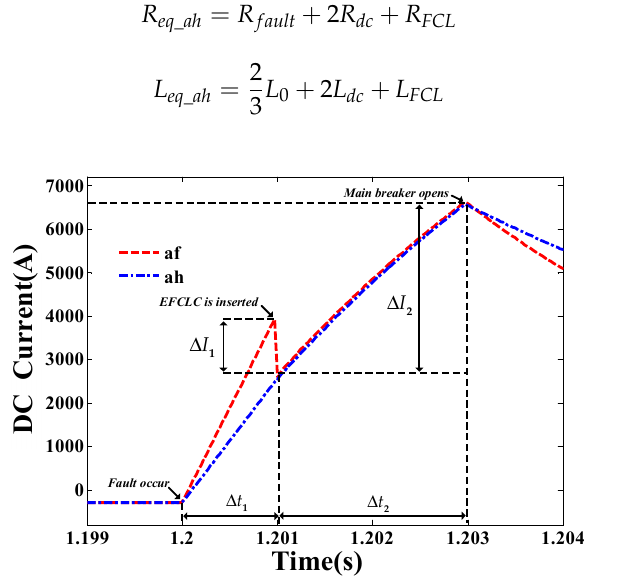
Figure 17. Simulation results of the DC line current with the EFCLC.